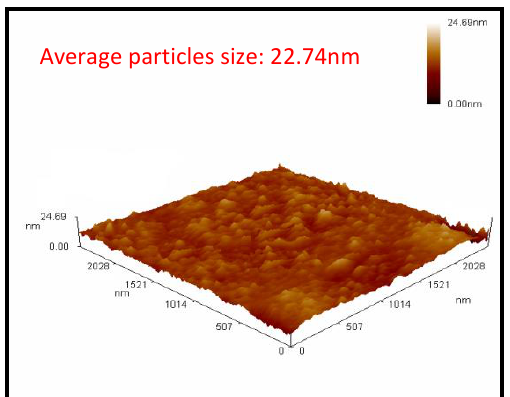
Particles size distribution: 11.97% Figure 21.AFM size distribution of polymeric gold nanoparticles